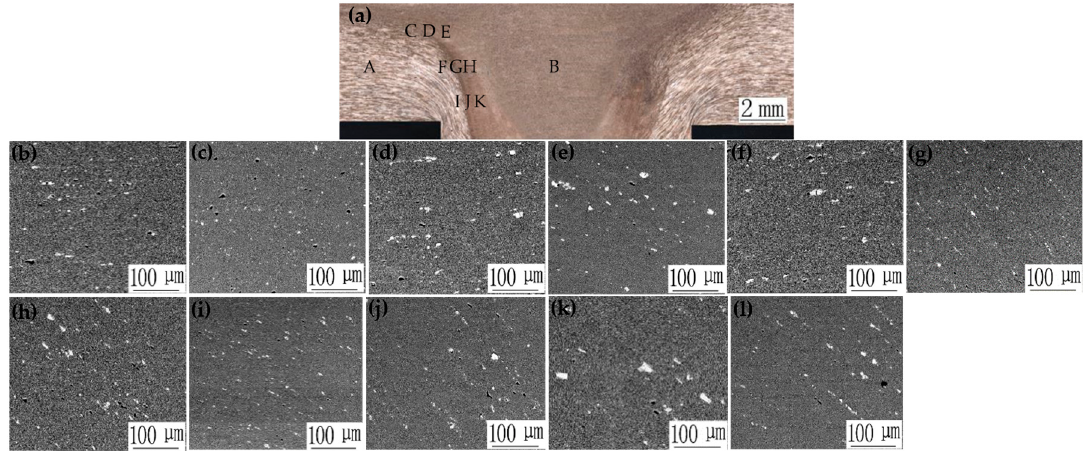
Figure 7. Scanning position and second phase distribution: ( a ) scanning electron microscope observation position, ( b ) area A, ( c ) area B, ( d ) area C, ( e ) area D, ( f ) area E, ( g ) area F, ( h ) area G, ( i ) area H, ( j ) area I, ( k ) area J, and ( l ) area K.